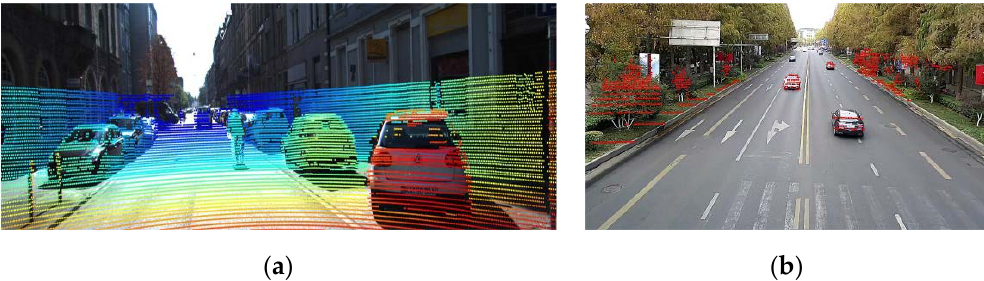
Figure 4. Examples of projected points on KITTI and private Roadside Dataset. We randomly choose an example in both datasets and project the points into the image. The outcomes are listed as the following: ( a ) the projected image on KITTI. These points are covered nearly all cars except for the occluded ones or far-off ones. ( b ) The projected image on Roadside Dataset. The distribution of unbalanced points makes it difficult to identify multi-scale vehicles. For example, the bottom right black car receives fewer points than the farther white one. We remove the points on the road for better visualization.